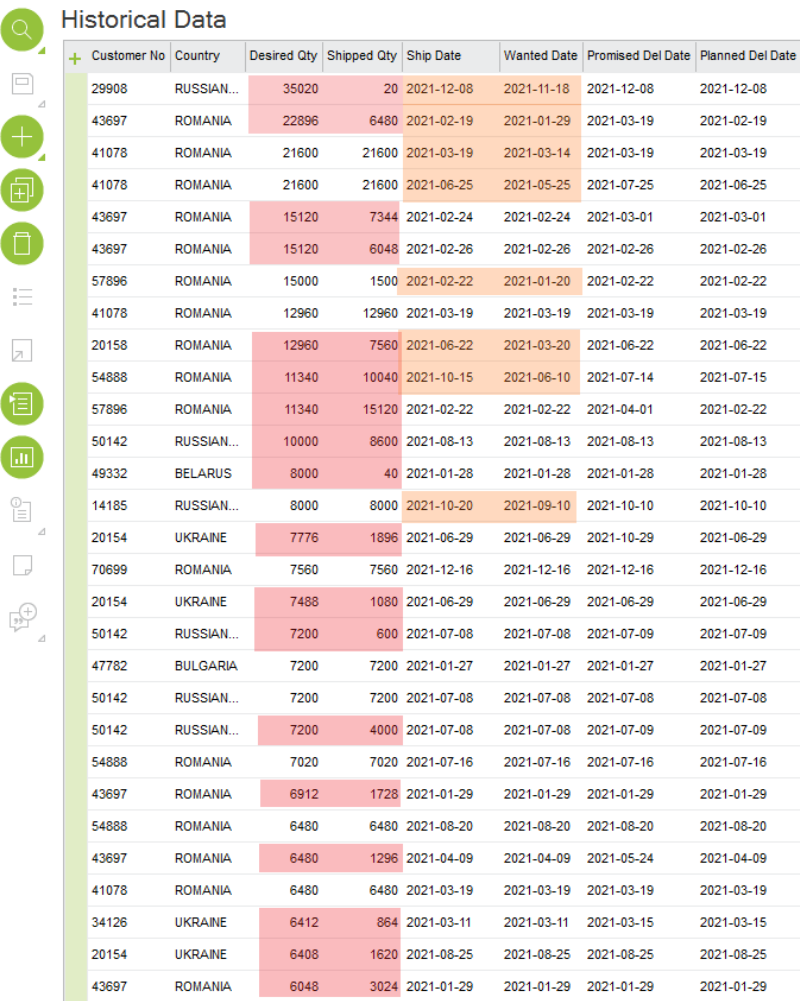
Figure 1. A screenshot from the ERP system showing historical real sales data from mass- customization industry. One can see the differences between the required quantity ordered by the customer (column Desired Qty) and the quantity shipped (column Shipped Qty) (highlighted in red), as well as the differences in the dates required by the customer (column Wanted Date), the planned delivery dates (column Planned Del. Date) and the delivery date (column Ship Date) (highlighted in orange). Adequate demand forecasting on the proper data inputs is expected to guarantee improved customer service in the future. From this small sample of randomly selected data, it can be seen that the vast majority of orders were not delivered in the specified quantities, and one in three orders had a significant delay in